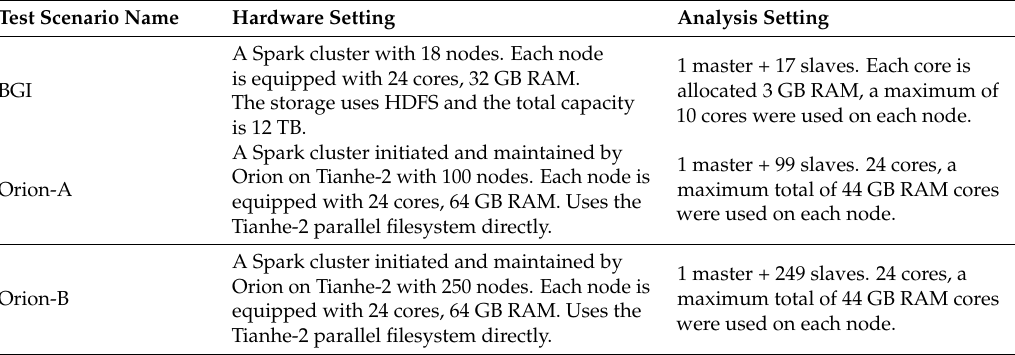
Table 3. Hardware and software settings of the Spark